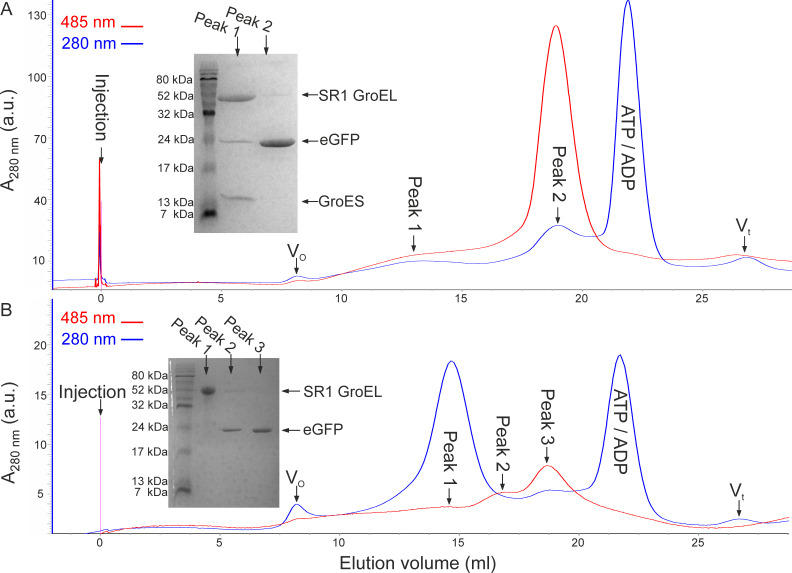
Isolation and stability of eGFP-containing single-ring GroEL in complex with GroES.(A) Freshly assembled eGFP-containing single-ring GroEL (SR1) complexes with GroES were applied to a gel-filtration column. The fractions were analyzed by SDS-PAGE (inset). The first peak, which was found to contain GroEL, GroES and eGFP, corresponds to eGFP-containing SR1 in complex with GroES. (B) Samples of eGFP-containing SR1 in complex with GroES were kept at overnight at room temperature and then analyzed by gel-filtration. Most of the eGFP was found in fractions (peak 3) that contain no GroEL and GroES (inset), thereby indicating that eGFP escaped from the cavity of the complex of SR1 with GroES. These experiments were repeated twice.